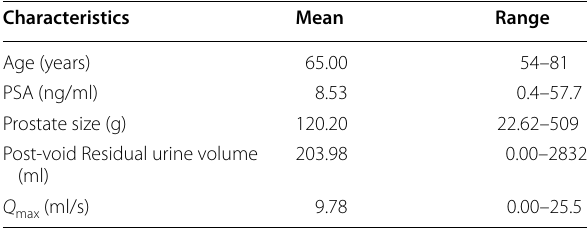
Table 1 Baseline pre-operative characteristics